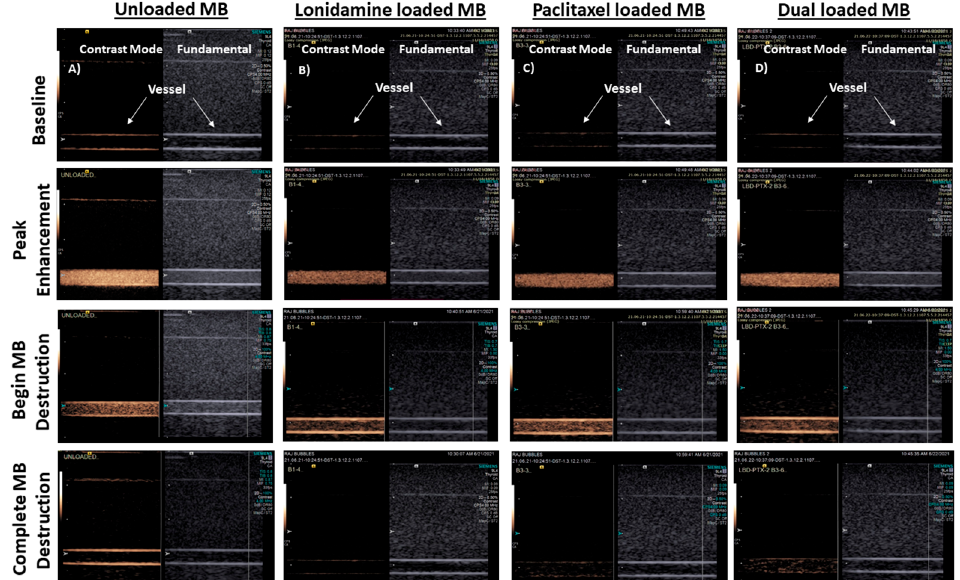
Figure 5. Effect of drug loading on performance in a tissue-mimicking flow phantom using SE61 O2 microbubbles (direction of flow right to left). Each image was taken at a focal length of 4 cm, displayed in both non-linear contrast mode (left-hand image in each panel) and fundamental B- mode (right-hand image), starting with pre-injection, empty vessels taken as the baseline images. Column ( A ) Unloaded, ( B ) Lonidamine-loaded, ( C ) Paclitaxel-loaded, and ( D )